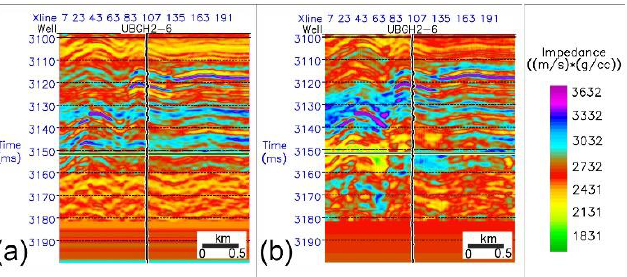
Figure 11. ( a ) Result of inversion with well-log and H3DS data only. Because the initial model to reduce uncertainty from missing low-frequency in H3DS data is composed of well-log only, the impedance shows periodical anomalies without reflecting lateral changes in the strata. ( b ) Result of stepwise seismic inversion using the inversion result of C3DS as a low-frequency initial model. Results reflect well the lateral changes of the strata.